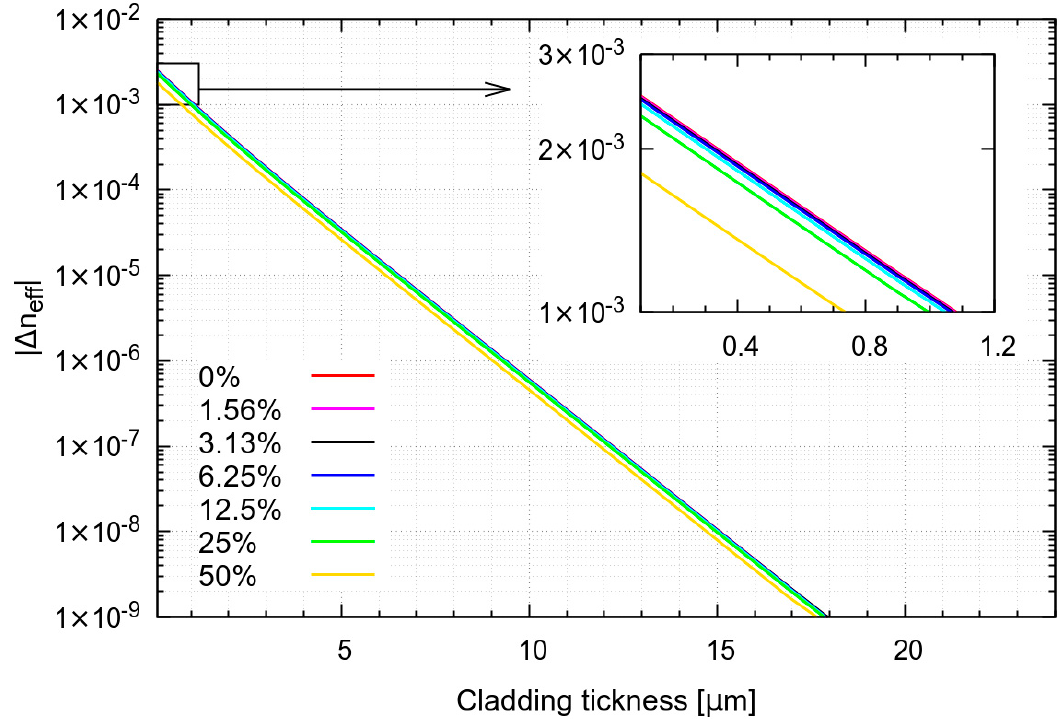
Figure 1. Effective index of fundamental mode with varying cladding thickness and sucrose concentration from 0% to 50% (weight/volume) in aqueous